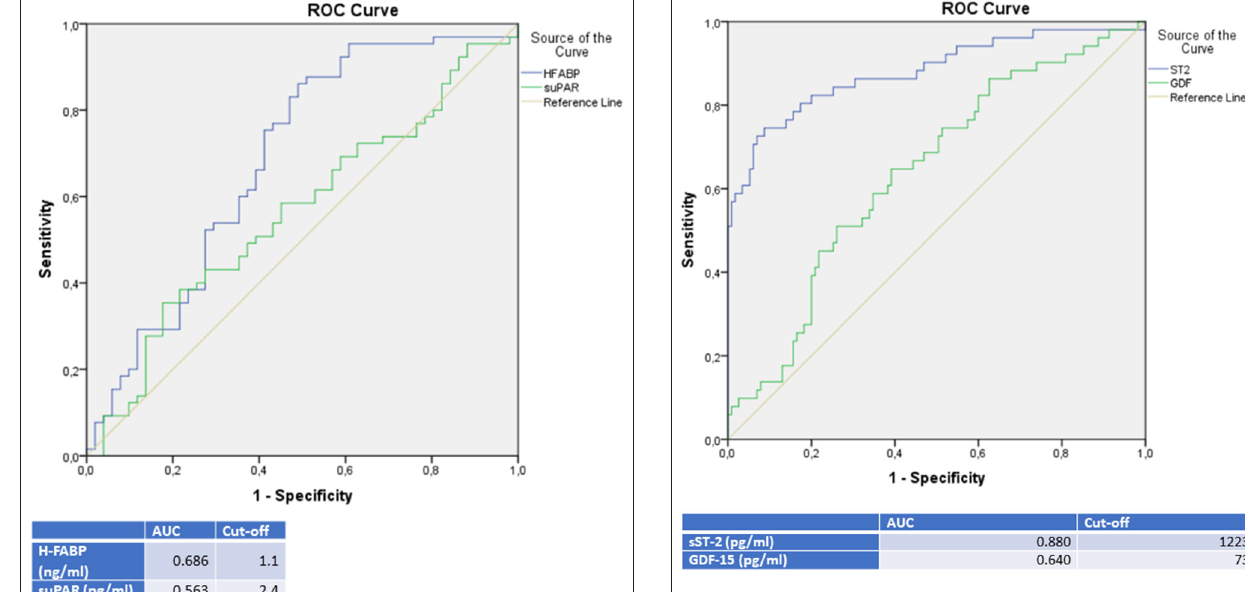
FIGURE 5 | ROC-Curves and cut off scores for sST-2 (ST2) and GDF-15 (GDF) prediction of TTC in the total cohort (including patients with TTC, DCMP, and